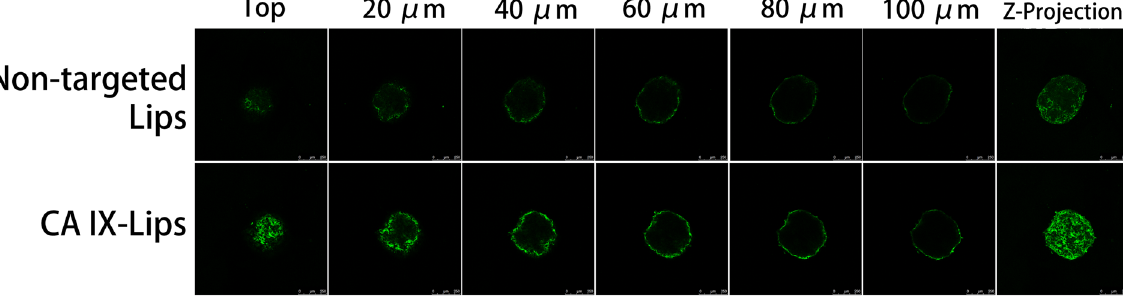
Figure 4. Uptake of NBD-DPPE-labeled CA IX-Lips and non-targeted Lips throughout A549 tumor spheroids. The distribution of liposomes were analyzed by CLSM using Z-stacking imaging with 20 μ m intervals. Scale bars, 250 μ m.